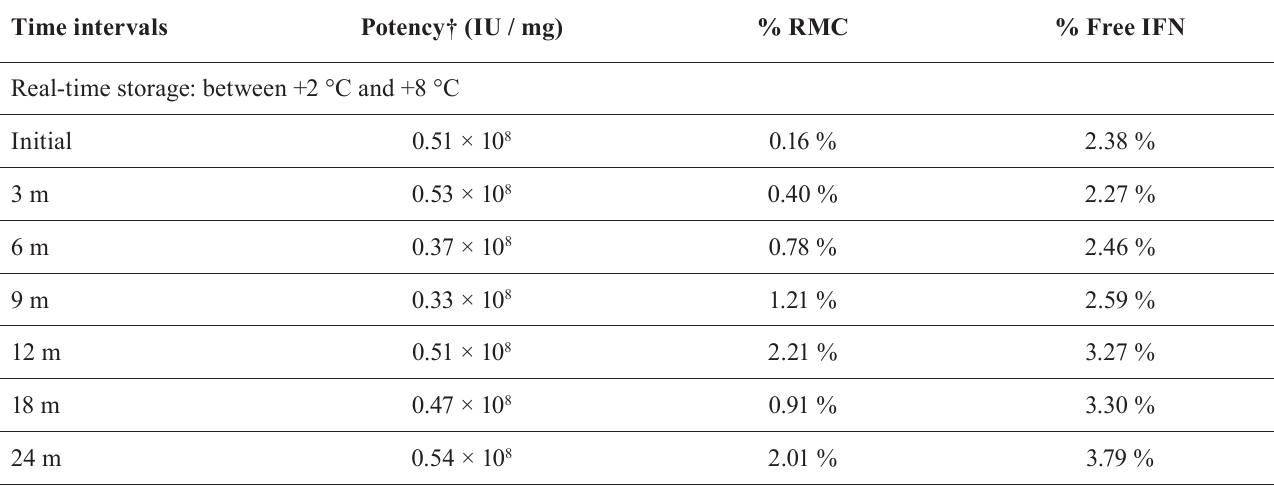
Peginterferon alfa-2b in Formulation D with one were withdrawn at different time intervals and analysed of the strength, 80 µg / 0.5 mL, was stored between +2 for various stability indicating parameters i.e. visual clarity after reconstitution, level of free interferon alfa-2b, °C and +8 °C to check stability upon long-term storage residual moisture content and potency. Results obtained up to at least 24 months. Samples were also exposed to higher temperature under accelerated storage conditions with samples exposed to different temperature conditions (25 °C ± 2 °C; 60 % RH ± 5 % RH) and stressed storage are summarized in Table VI. conditions (40 °C ± 2 °C; 75 % RH ± 5 % RH). Samples TABLE VI - Formulation D with 80 µg / 0.5 mL strength – exposed to different temperature conditions